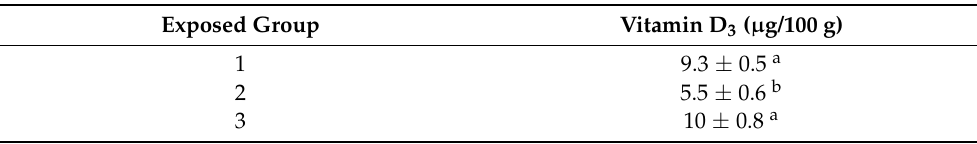
A different letter (a, b) next to the value indicates a significant difference ( p ≤